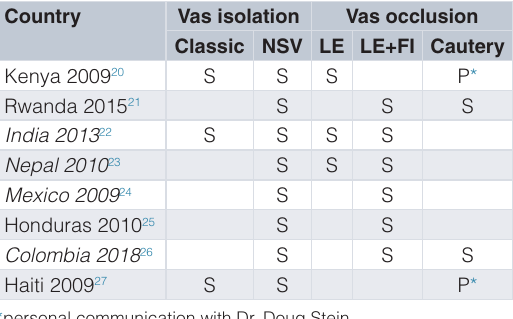
Table 2. National standards and practices for exposing and occluding the vas deferens in selected low- resource countries. Countries with large vasectomy programs are in